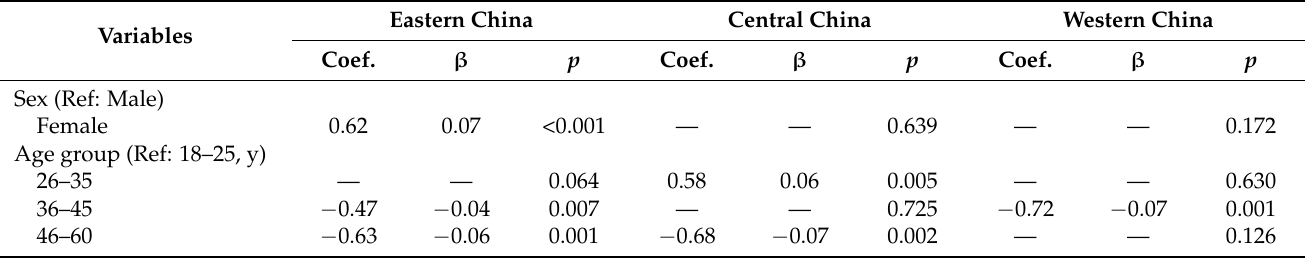
Table A7. The stepwise regression of associated factors for EBS-SF scores stratified by